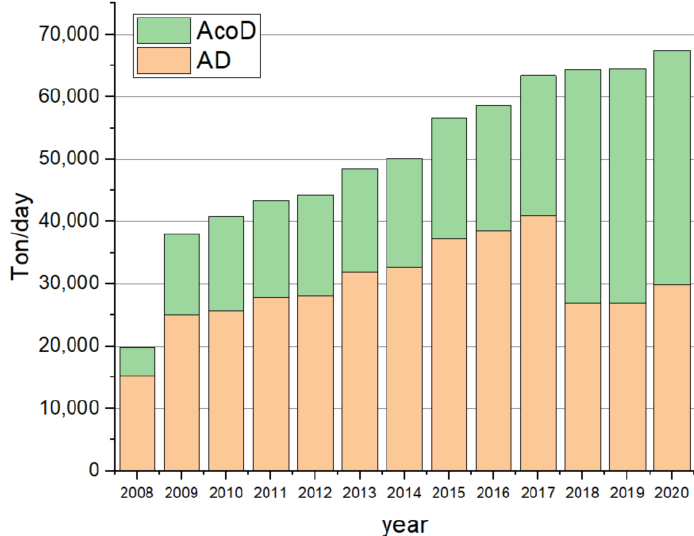
Figure 1. Total capacity of digestion facilities in South Korea.